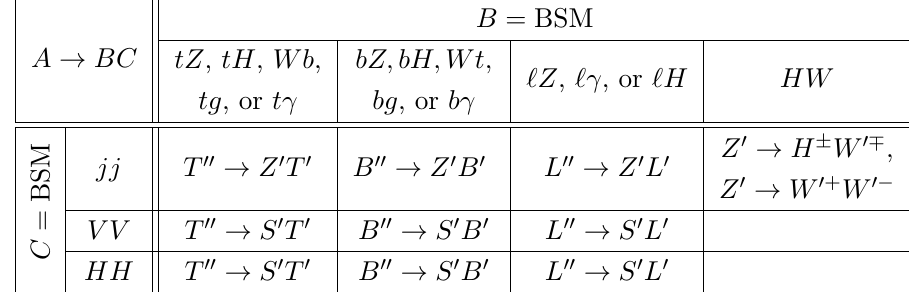
Table 6 . Example (Group VI in table 1) for A ! BC , where A , B and C are BSM particles. The C decays to two similar SM particles, while the B decays to two di(cid:11)erent kinds of SM particles. The jj denotes a diquark with all possible (cid:13)avor combinations. The V V includes gg; (cid:13)(cid:13) , (cid:13)Z , ZZ , or WW .